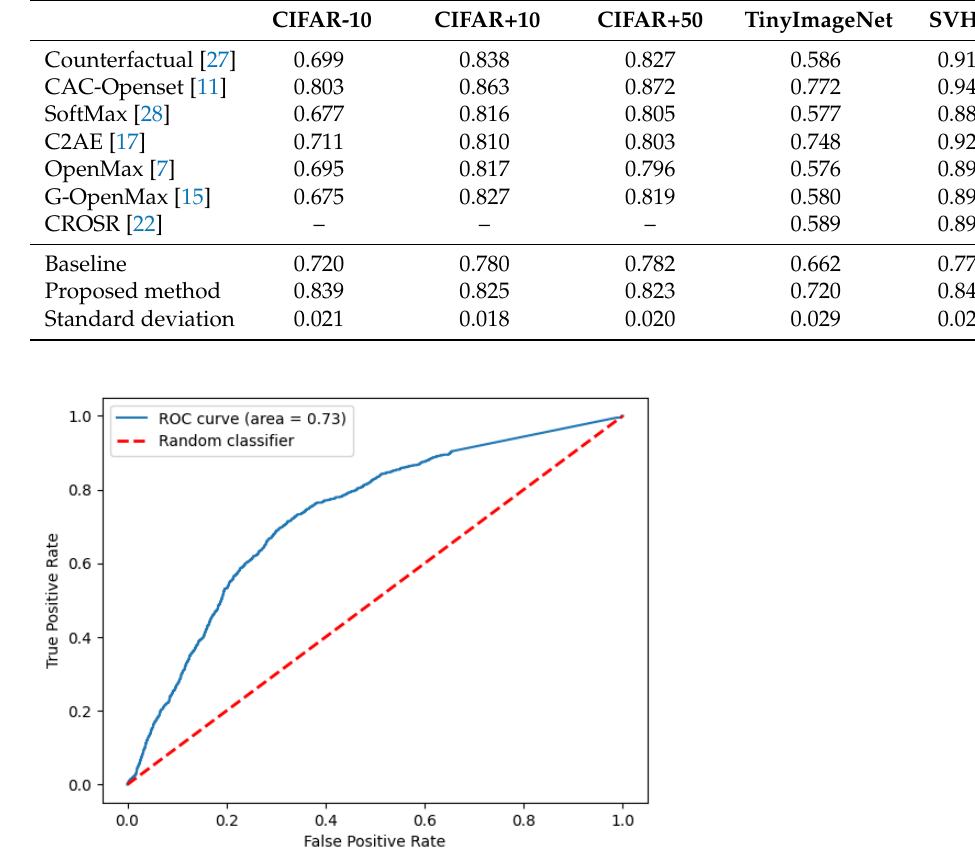
Table 2. Open-set detection performance in terms of AUC value.